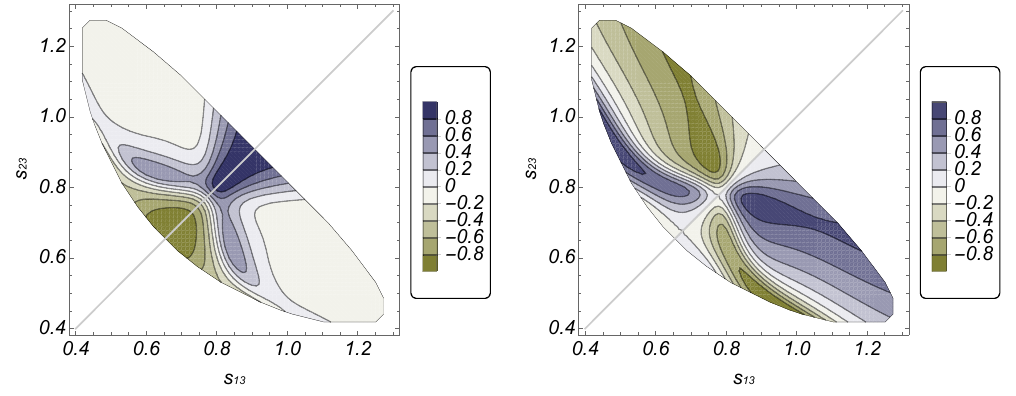
Figure 2 . Normalised distributions of the real (left) and imaginary (right) parts of eq. (5.8) decay amplitudes. While the real part (a δp ) is symmetric with with K 1 (1270) K ∗ π π + π − K 0 S → → respect to the Dalitz-plane bisector, the imaginary part (b δp ) exhibits an anti-symmetric pattern. and s 23 = m 2 in GeV 2 /c 4 . A similar behaviour is The axes correspond to s 13 = m 2 π + K 0 S π − K 0 S observed for all kaonic resonances.